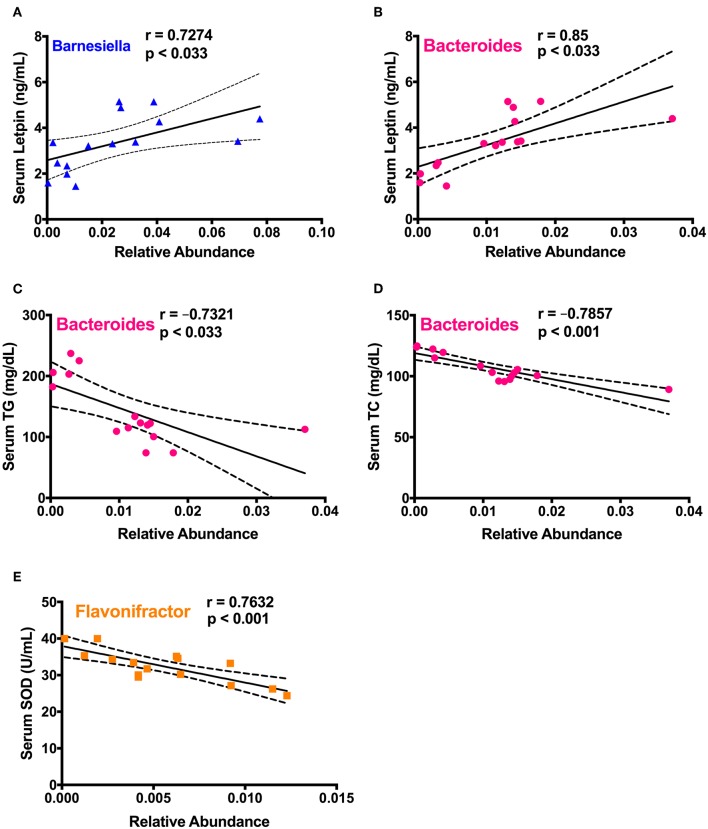
Spearman correlation analysis between the differentially abundant cecal microbial taxa and biological markers in mice. (A)
Barnesiella and serum leptin level; (B–D)
Bacteroides and the levels of serum leptin, TC, and TG, respectively; (E)
Flavonifractor and serum SOD activity. Spearman correlation coefficient (r) and p-value were computed from a linear regression analysis in R, and a regression line with the 95% confidence interval were plotted. The absolute value of r > 0.7 and p < 0.033 were considered to be statistically correlated with each other.